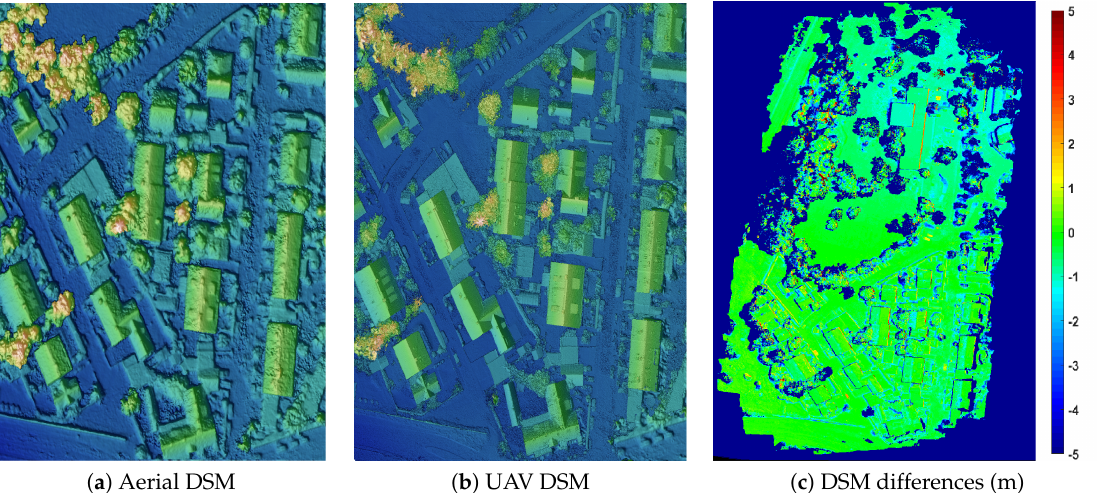
Figure 15. Comparison of ( a ) aerial and ( b ) UAV DSM of the Eichenau dataset. 20-cm GSD for aerial and 2-cm GSD for UAV DSM. ( c ) Color map illustrating the height differences between the two DSMs in meters.